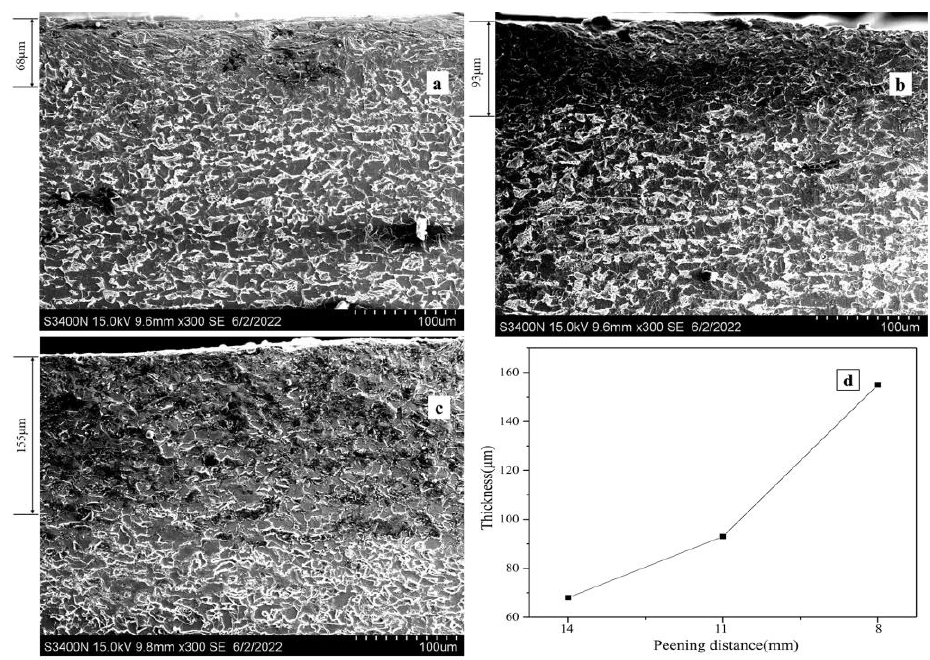
Figure 4. The cross-sectional SEM microstructure of the 3 mm-200 s-2080 W sample: ( a ) 14 mm; ( b ) 11 mm; ( c ) 8 mm. ( d ) The thickness statistics of the shot peening deformation layer with different distances.